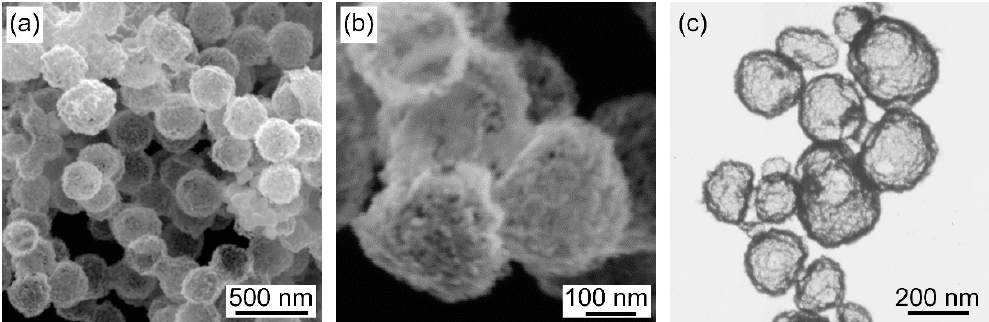
Figure 4. ( a ) Low- and ( b ) high-magnification FESEM and ( c ) TEM images of the SnO 2 spheres prepared by using the wheat-derived carbonaceous particles as template.